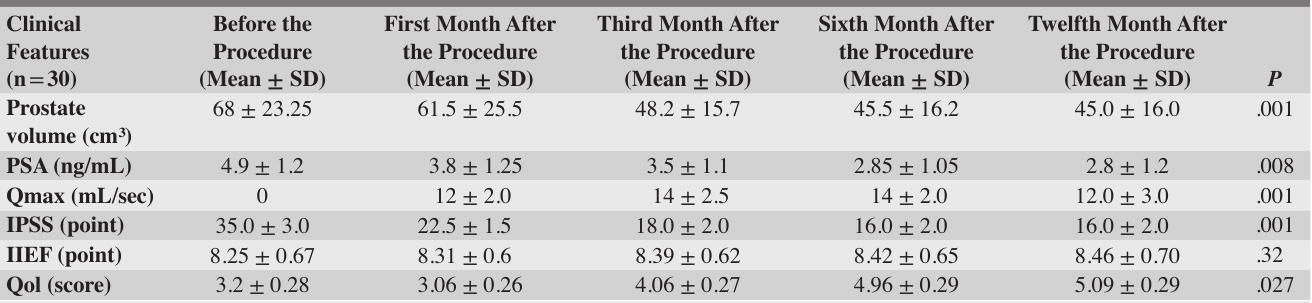
Table 2. Clinical Values of the Patients Before and After the Procedure